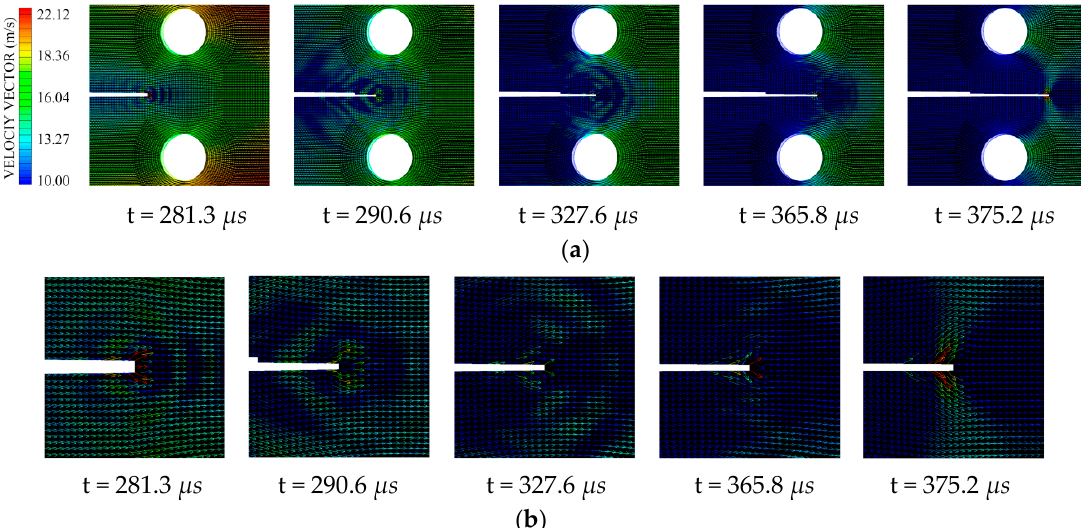
Figure 13. Numerical (ATUODYN) results of the B16-D30 specimen. ( a ) Velocity vector contour in the central zone of the connection line between two holes. ( b ) Particle velocity vector on the crack tips.